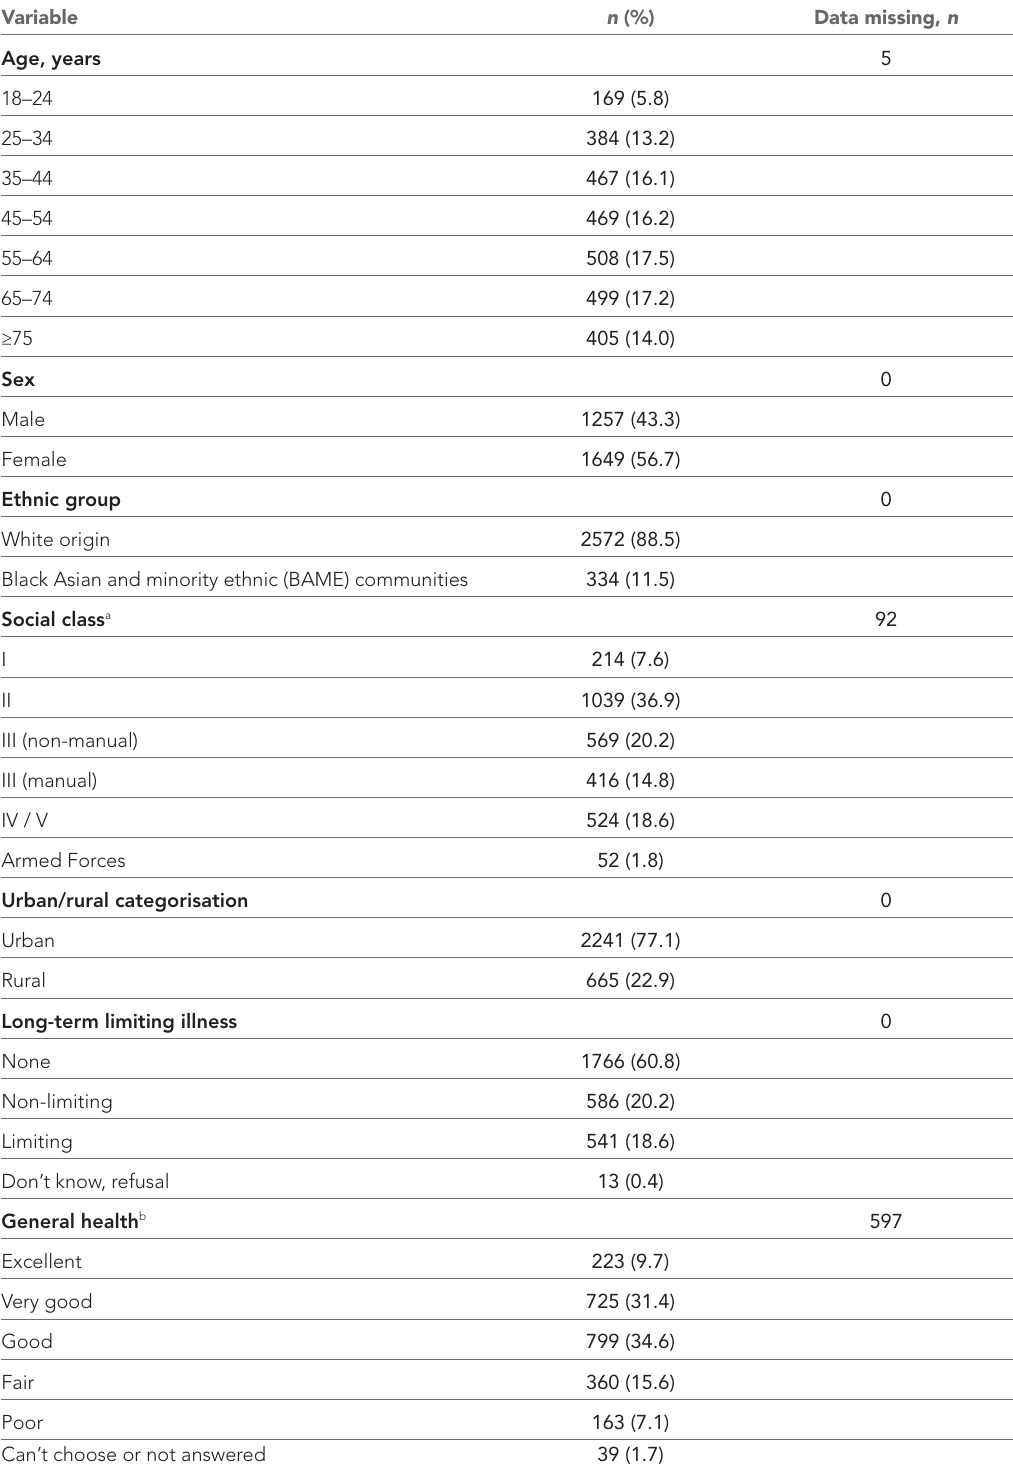
Table 2 Characteristics of the survey sample, N =